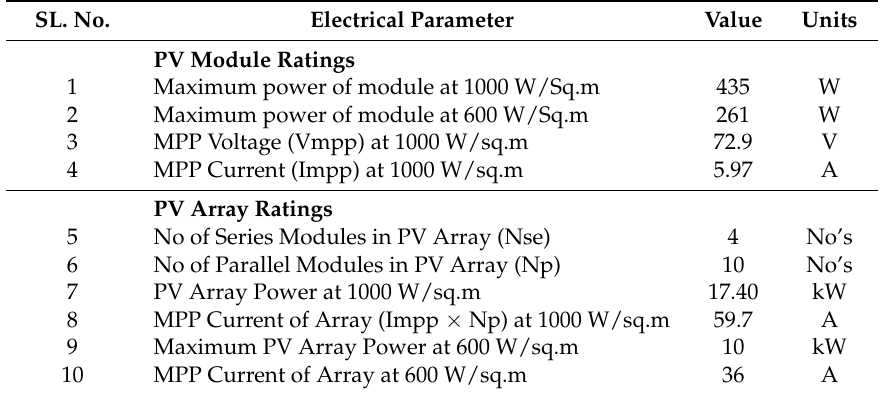
Table 4. Parameters of Programmed PV-Array at Irradiance Inputs of 1000 W/Sq.m and 600 W/Sq.m. SL. No.